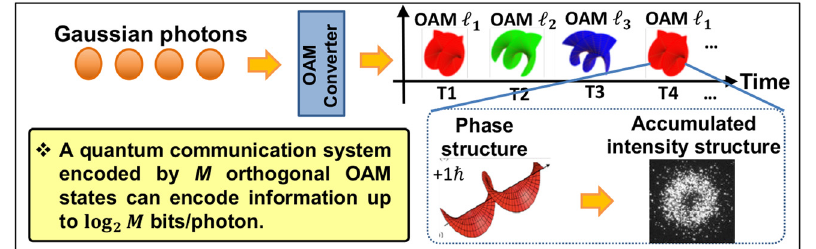
Figure 7: Concept of orbital-angular- momentum (OAM) – based quantum data encoding. Within each symbol period, a Gaussian photon is converted to one of the encoding of up to log 2 M bit/photon. The recorded using a single-photon sensitivity, device camera